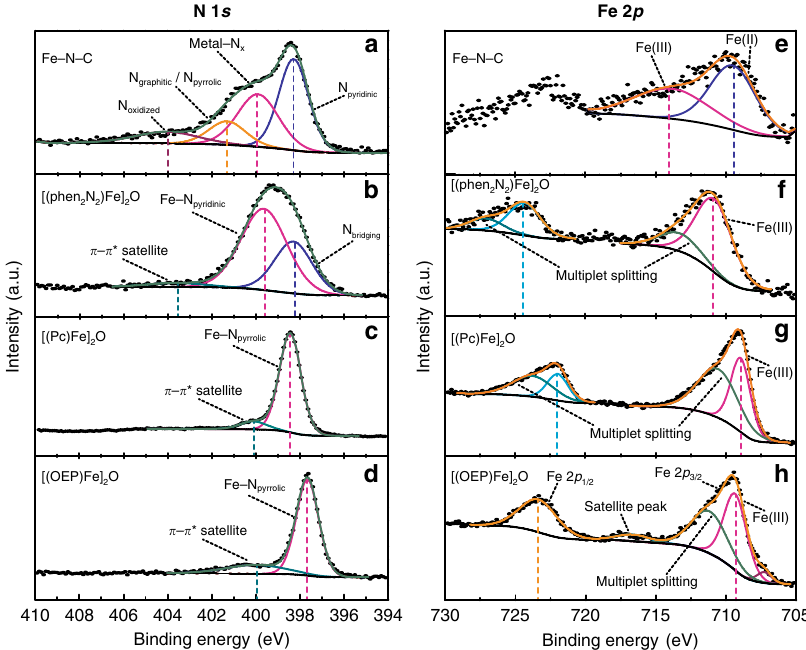
Fig. 3 High-resolution N 1 s and Fe 2p XPS spectra. Fe-N-C ( a and e ), [(phen 2 N 2 )Fe] 2 O ( b and f ), [(Pc)Fe] 2 O ( c and g ), and [(OEP)Fe] 2 O ( d and h ). In the N 1s spectra, pyridinic and bridging nitrogens are depicted in blue, metal-coordinated nitrogens are depicted in magenta, graphitic/pyrrolic nitrogens are depicted as yellow, oxidized nitrogens are shown in purple and the π – π * satellites are shown in dark cyan. In the Fe 2p spectra, the 2p 3/2 Fe(II) peak is shown in blue and the 2p 3/2 Fe(III) peak is given in magenta. The Fe 2p 1/2 peak is given in aqua blue. Multiplet peaks for the 2p 3/2 and 2p 1/2 peaks are given in green and dark cyan,